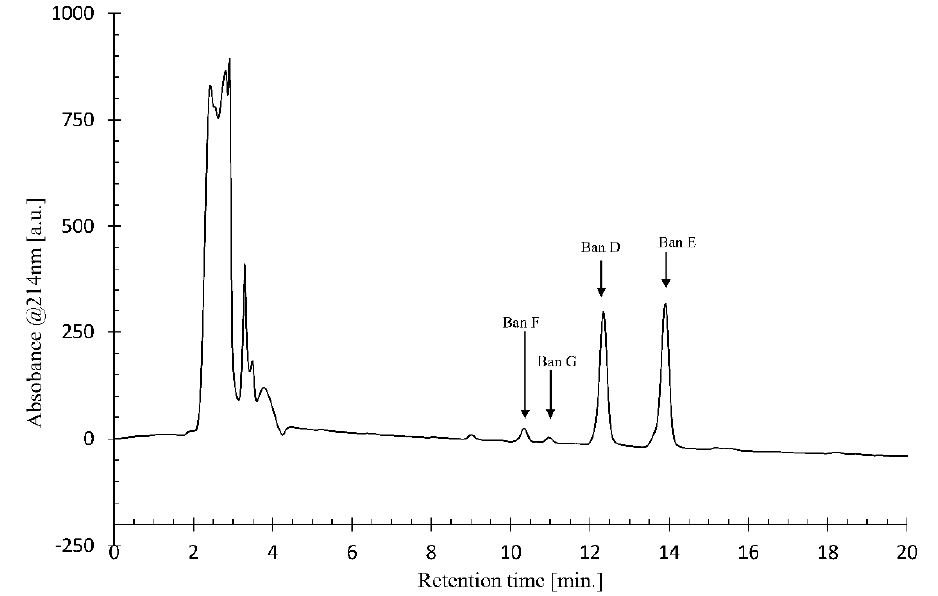
Figure 2. Chemical analysis of crude CLP samples from Pseudomonas sp. COW3.